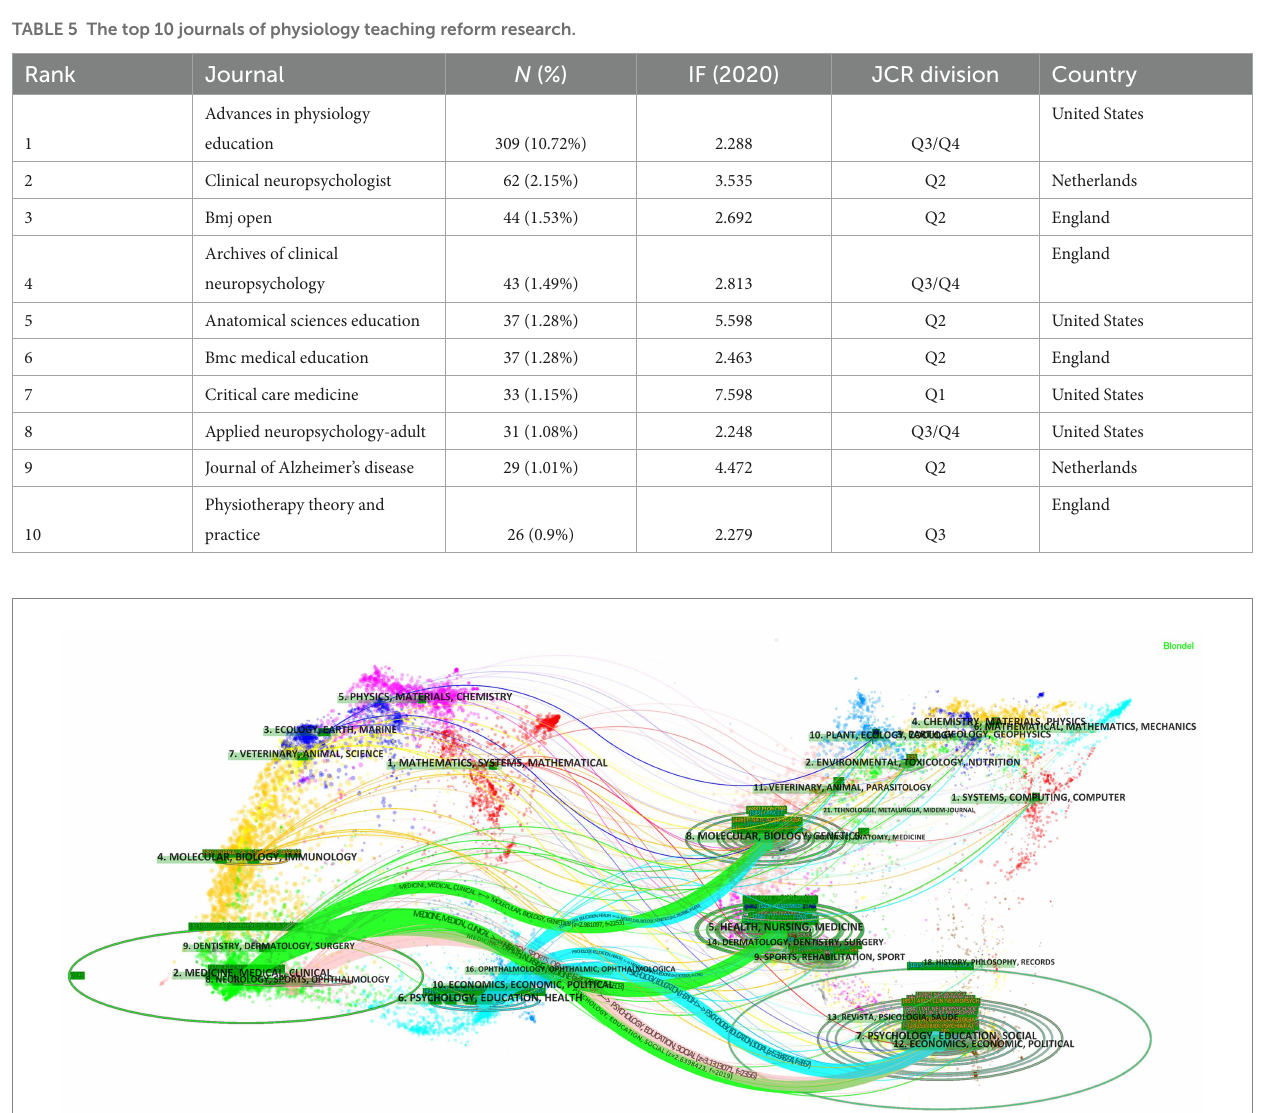
FIGURE 8 The dual-map overlay of journals related to physiology teaching reform research. The citing journals were at left, the cited journals were on the right, and the colored path represents citation